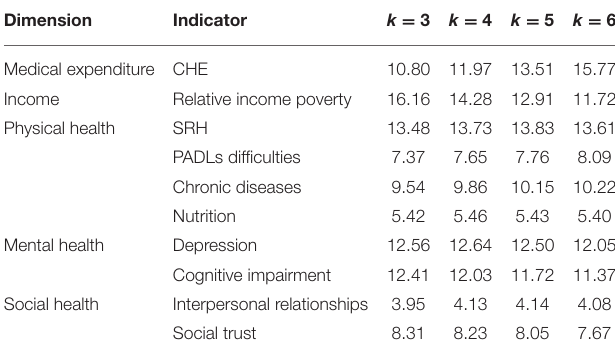
TABLE 5 | Decomposition of MHPI under equal weights by all